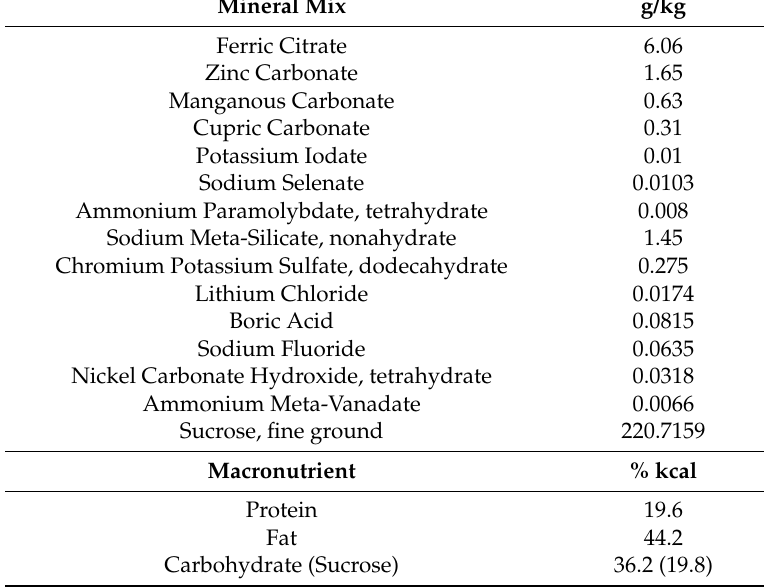
vitamin D AIN93G diet.